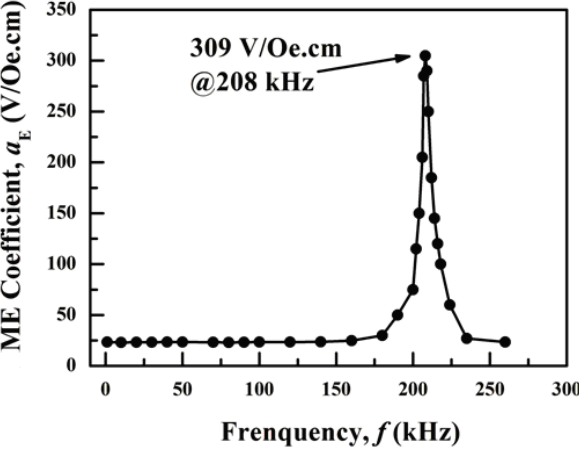
Figure 3. Dependence of frequency on the ME coefficient for the Permendur/PZT laminate at the dc bias magnetic field of ~250